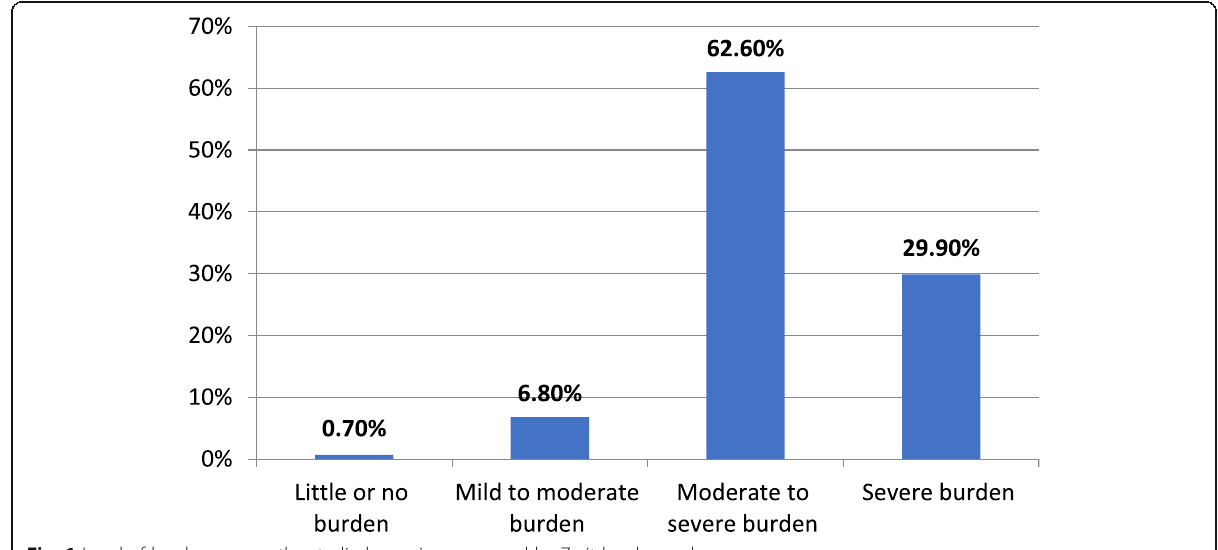
Fig. 1 Level of burden among the studied caregivers assessed by Zarit burden scale